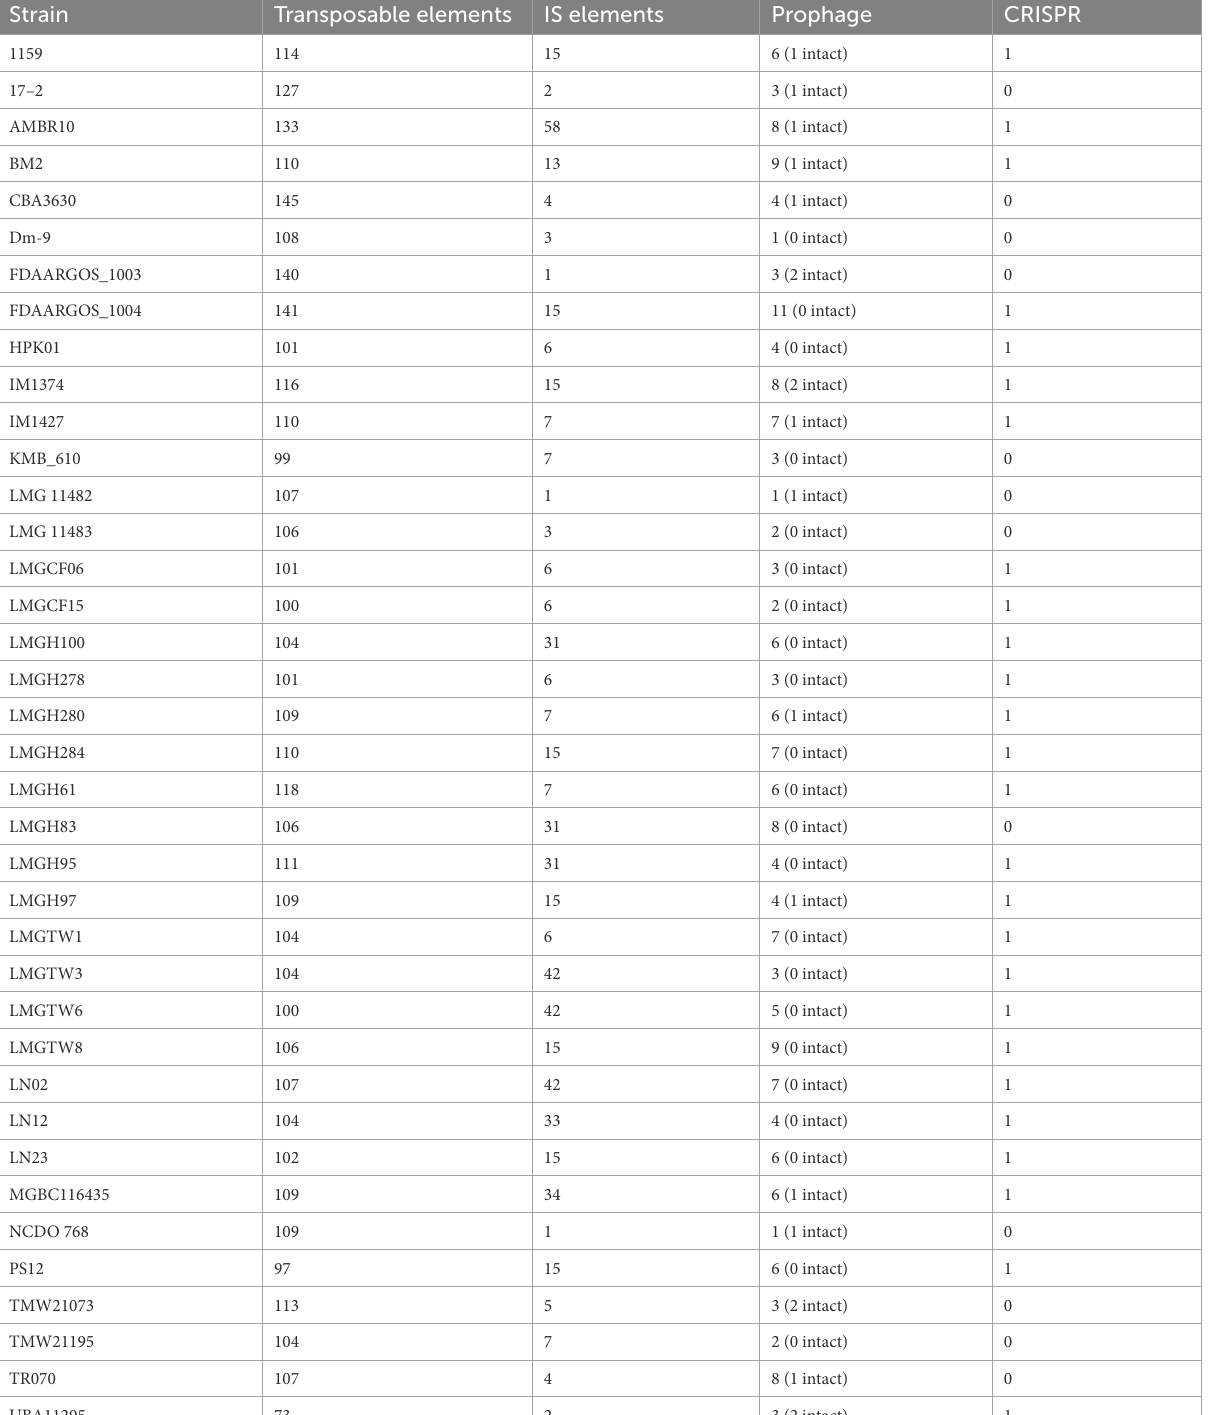
TABLE 4 Putative mobile genetic elements of Ln. pseudomesenteroides. Strain Transposable elements IS